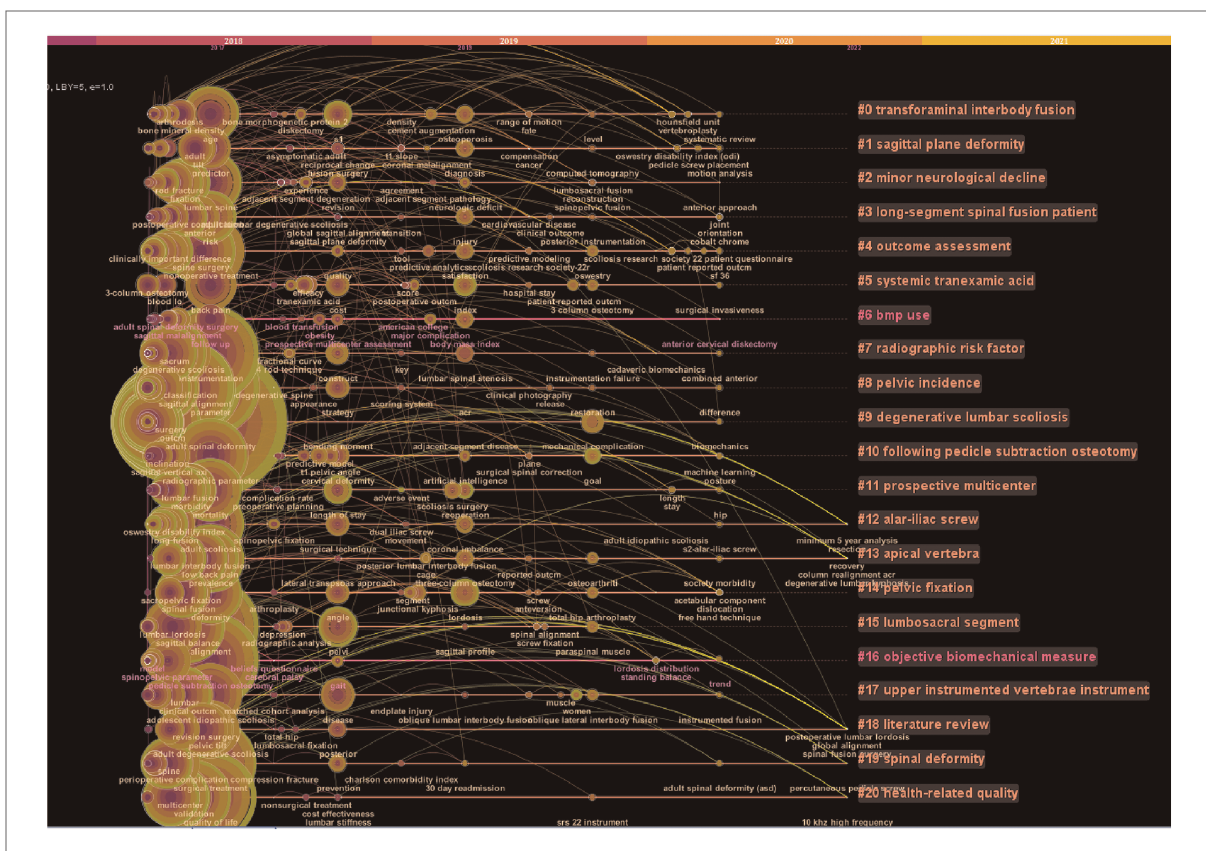
FIGURE 7 Timeline visualization of author keywords based on CiteSpace (from 2017 to 2022). The node represents the time when the keyword fi rst occurs. The larger the node, the more times it appears. The clustering label was obtained by CiteSpace software according to the timeline on the right of the fi gure. Each row in the fi gure shows the occurrence of the keyword in different years. The line between each node represented the correlation and the different colors implied the diverse time, the purple line was the oldest (2017), while the yellow line was the newest